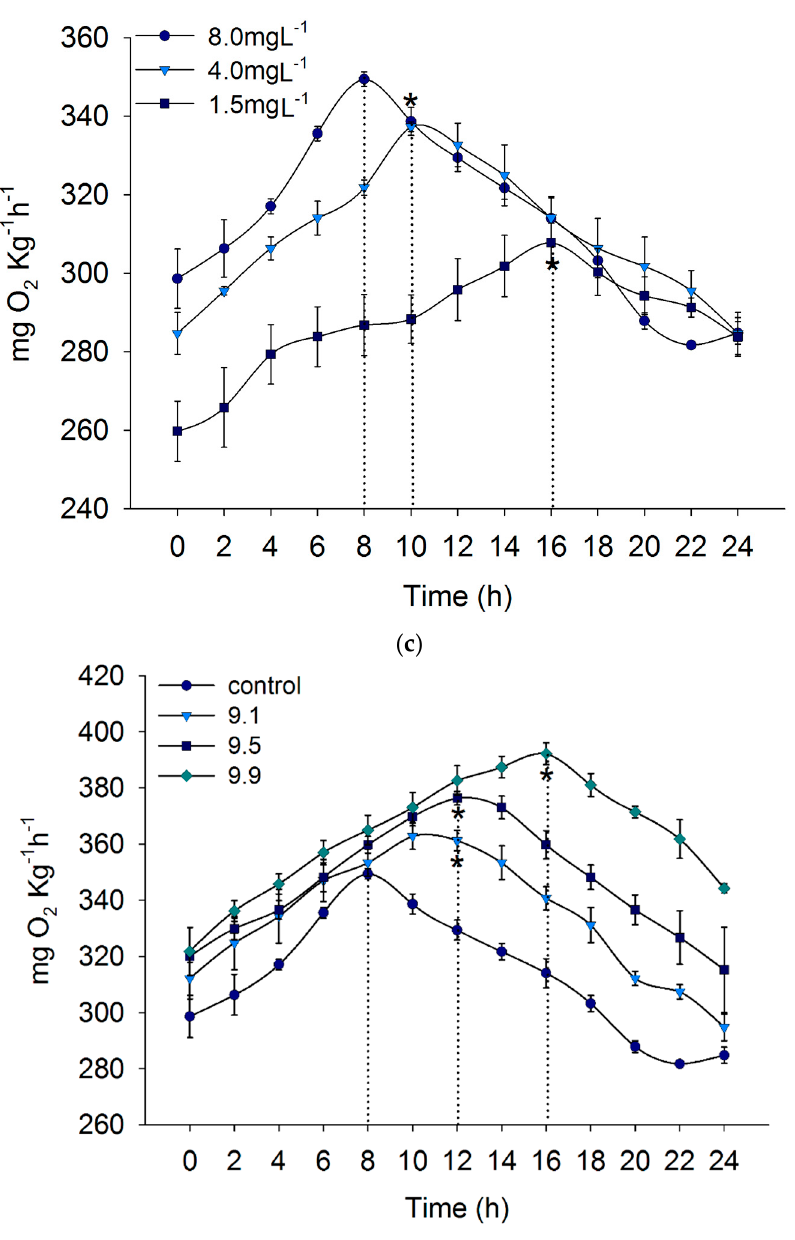
Figure 2. Post-prandial MO 2 of Carassius auratus gibelio exposed to high ammonia (control, 0.5 mg L − 1 , 1.0 mg L − 1 , 2.0 mg L − 1 ) ( a ), high nitrite (control, 0.5 mg L − 1 , 1.0 mg L − 1 , 1.5 mg L − 1 ) ( b ), hypoxia (control, 4.0 mg L − 1 , 1.5 mg L − 1 ) ( c ), and high pH (control, 9.1, 9.5, 9.9) ( d ).Values are means ± SE. Statistically